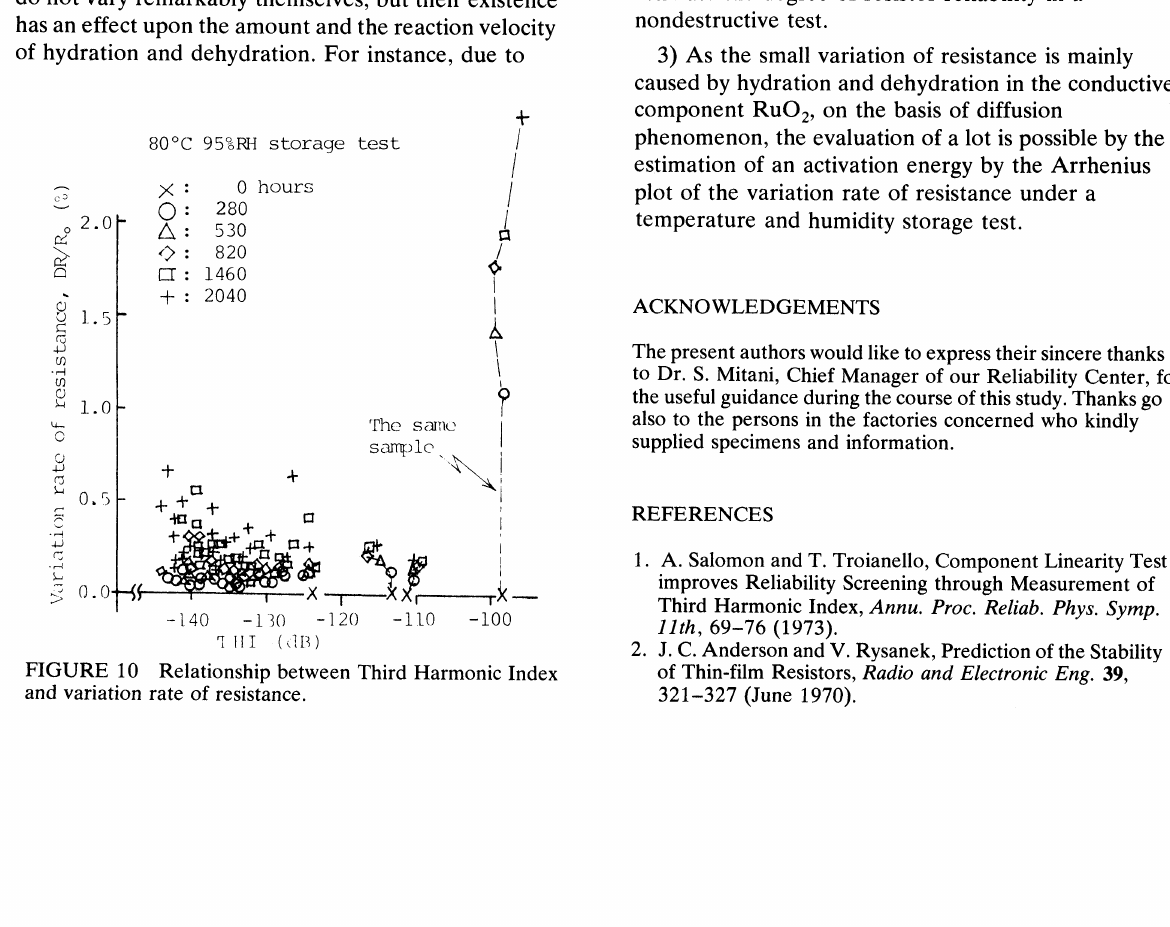
FIGURE 10 Relationship between Third Harmonic Index and variation rate of